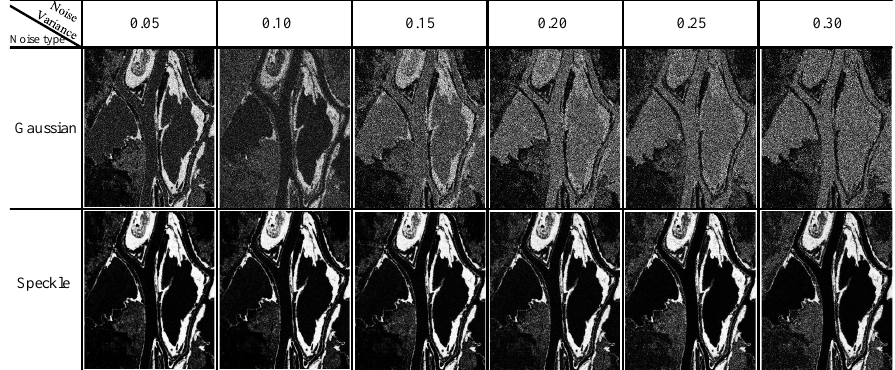
Figure 26. The DIs with different levels of different noises on the Ottawa data set.